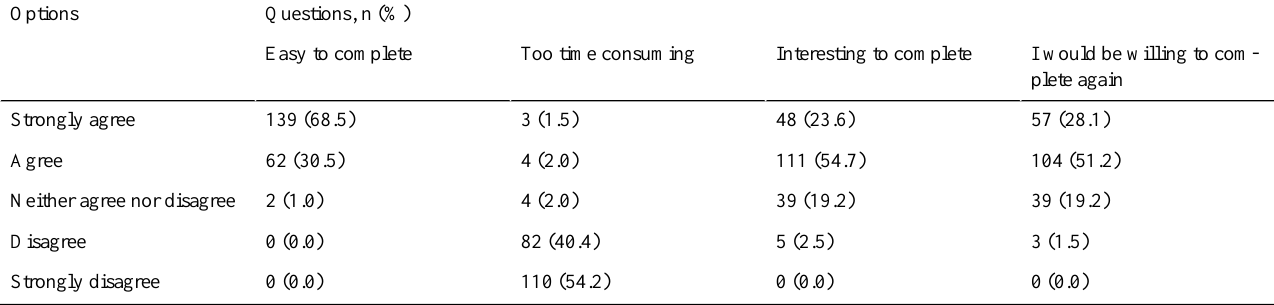
Table 14. Responses of the study participants to the usability rating questionnaire for the electronic 12-hour dietary recall app (part 1).